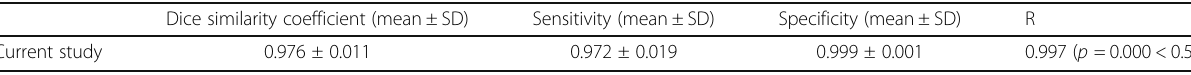
Table 1 Segmentation performance with threshold value of